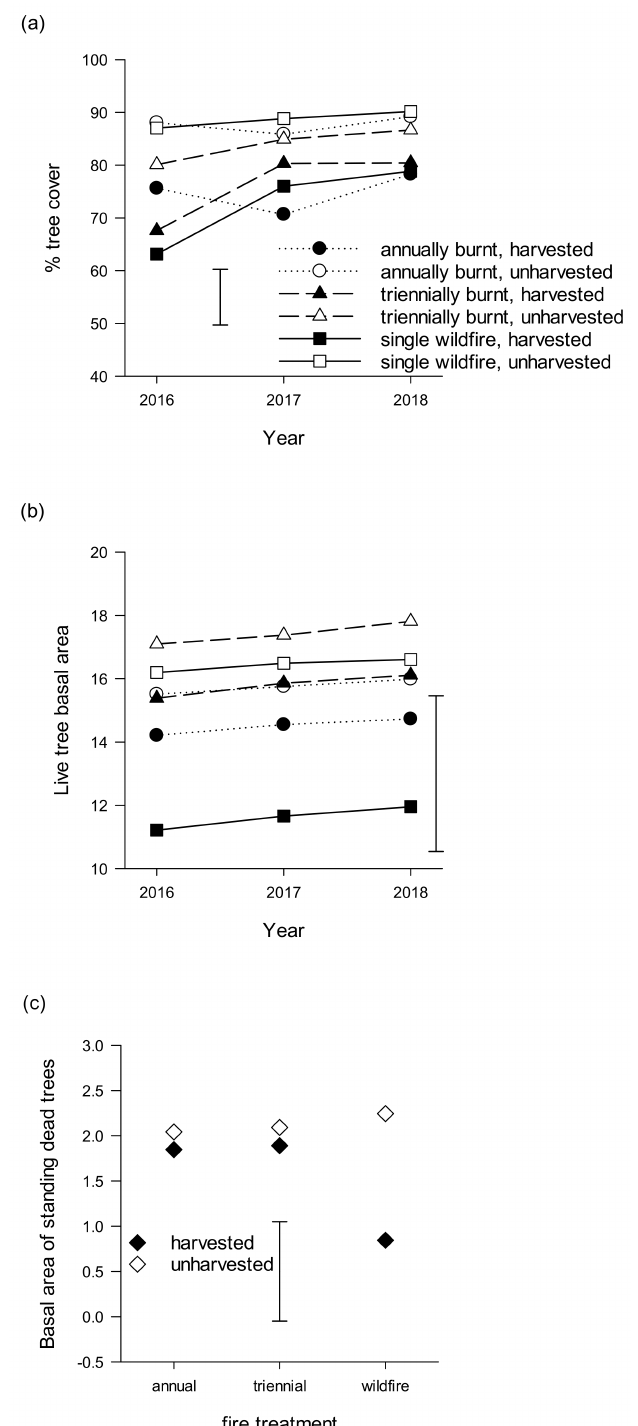
Figure 2. Variation in mean ( a ) tree cover (%) and ( b ) live tree basal area (m 2 /ha) over time after harvesting (in 2015) in the different harvesting and fire treatments, where there was a significant time × fire treatment × harvesting interaction ( p < 0.001) for tree cover, but no significant interaction ( p > 0.05) for live tree basal area; and ( c ) variation in the basal area of standing dead trees in the different harvesting and fire treatments, where the fire treatment × harvesting interaction was significant ( p = 0.009). The error bar indicates the LSD in each case. Ground-layer biomass of living vegetation varied significantly between harvested and unharvested areas (F 1,12 = 13.65, p = 0.003), but fire treatment effects, variation